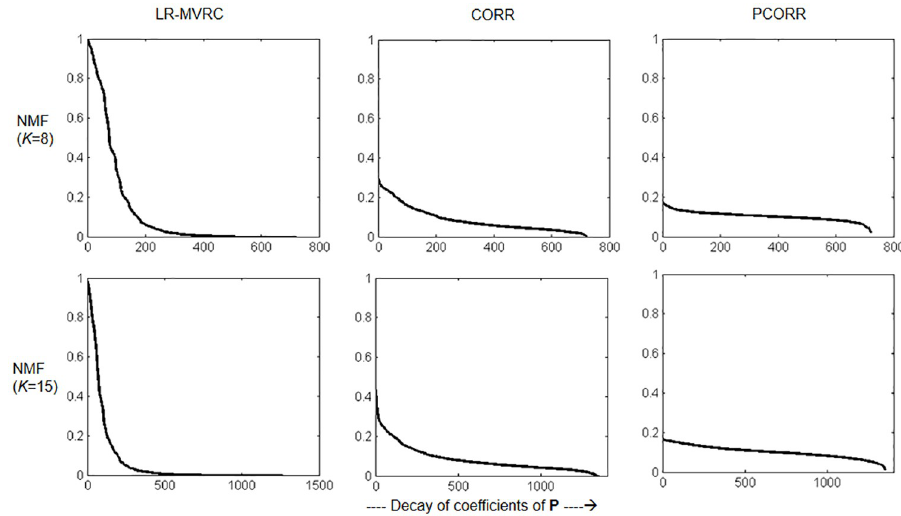
Fig 2. Illustration of sparsity of matrix P obtained with NMF. Plot of sorted coefficients of matrix P , obtained using LR-MVRC, CORR and PCORR matrices with different values of K in NMF.